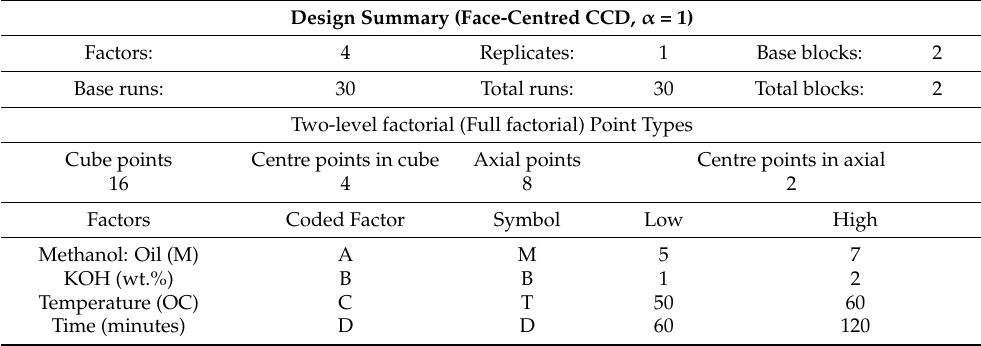
Table 12. Central composite design (CCD) algorithm for the transesterification process of esterified